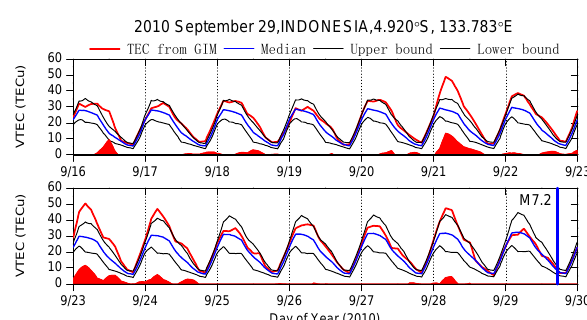
Fig. 16. VTEC time series above the Indonesian epicenter during 16 September 2010 to 29 September 2010. Symbols in this figure are the same as those in Fig. 3.